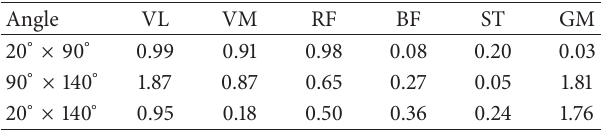
Table 1: Effect size ( 𝑑 ) comparisons for iEMG between knee joint- angle positions.